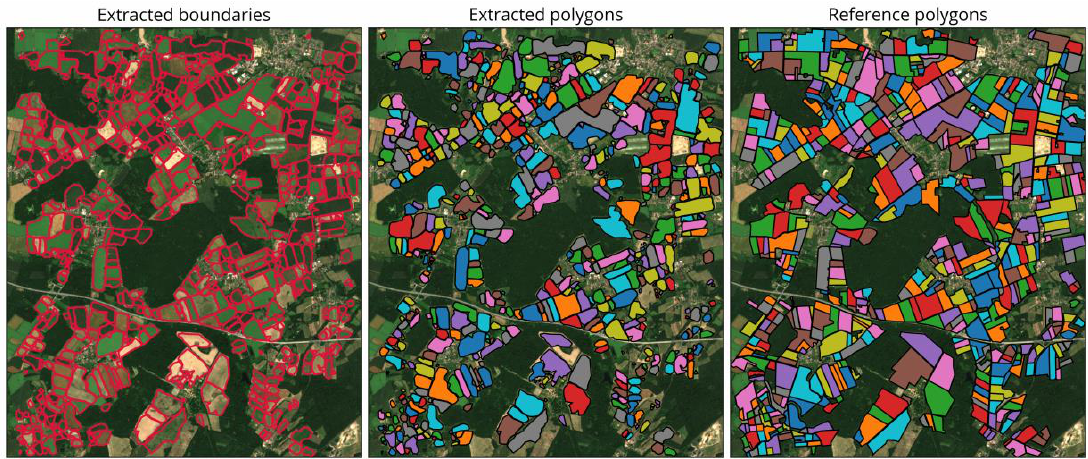
Figure 7. Result of the adaptive graph-based growing contours (GGC) field polygon extraction.